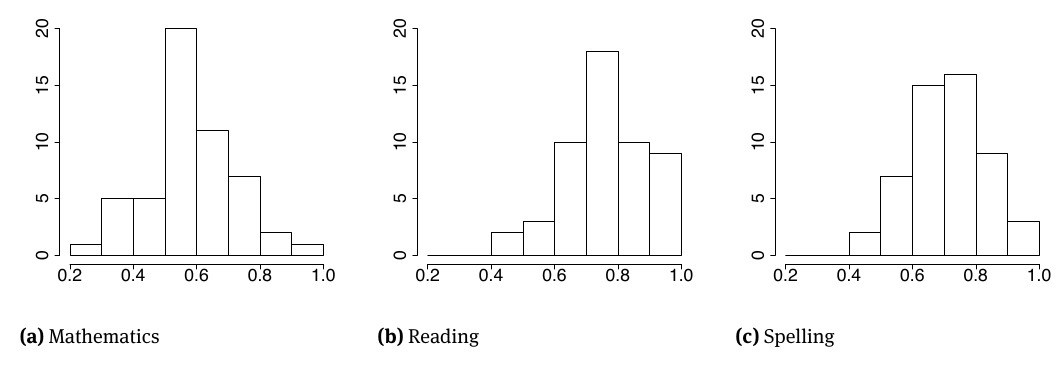
Figure 1: Frequency histograms.